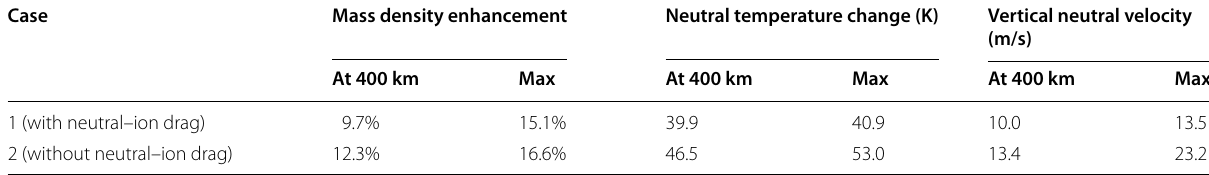
Table 1 The resulting mass density enhancements, neutral temperature change, and vertical neutral